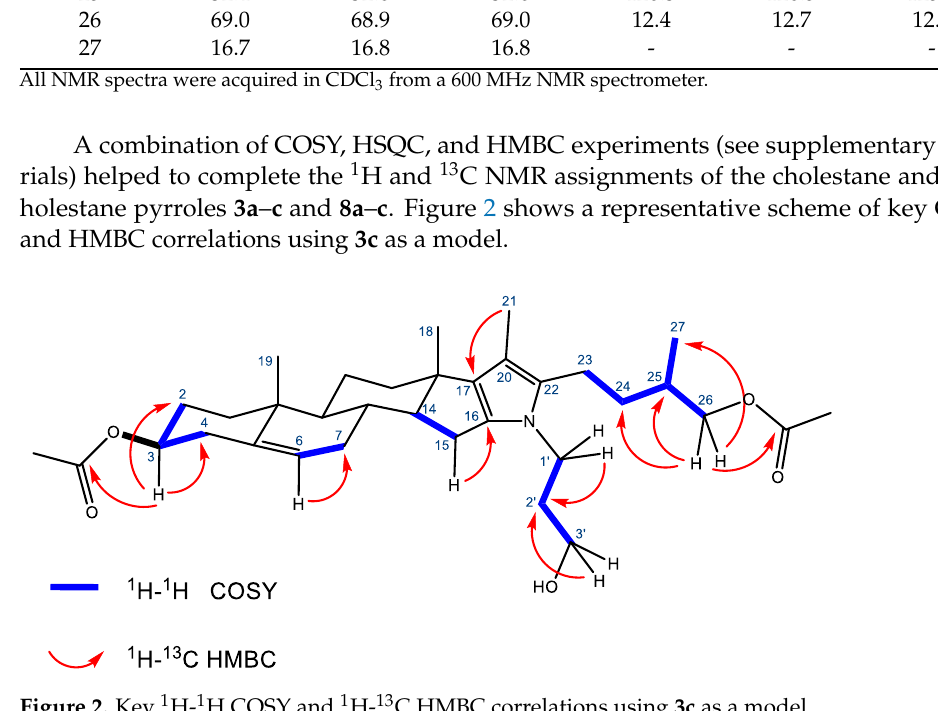
Figure 2. Key 1 H- 1 H COSY and 1 H- 13 C HMBC correlations using 3c as a model.